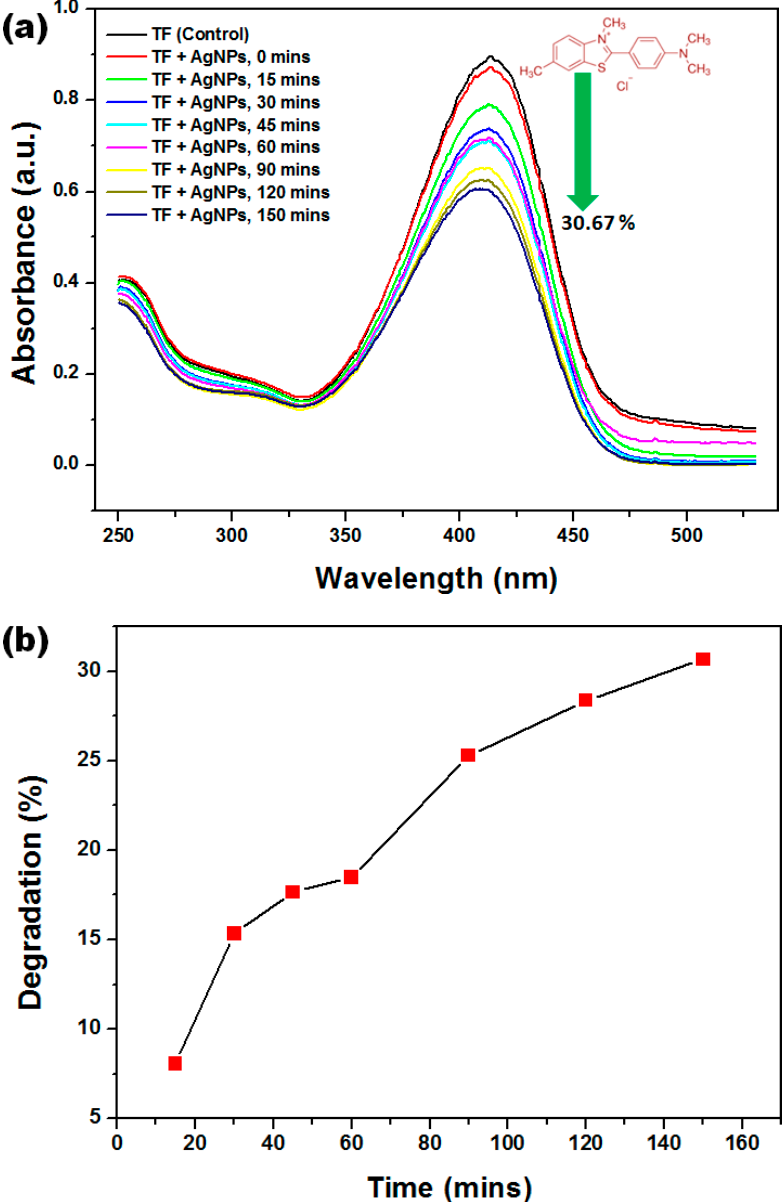
Figure 7. ( a ) Photocatalytic degradation pattern and ( b ) degradation % of TF using synthesized AgNPs at different sunlight exposure times by observing changes in absorbance at 413 nm.